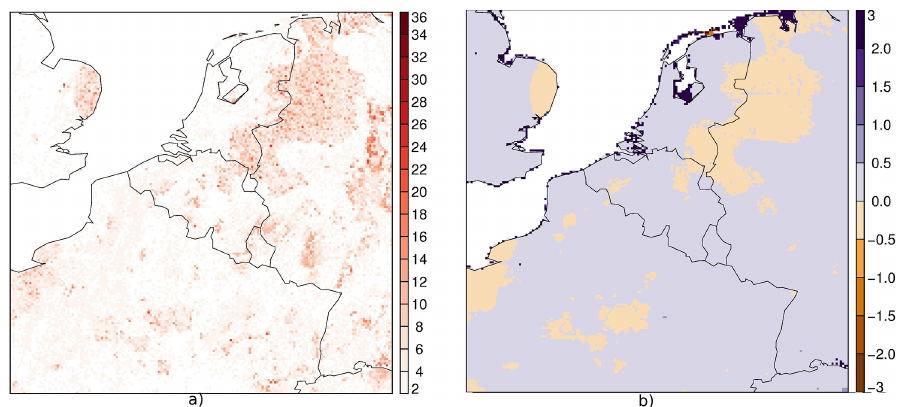
Figure 6. The number of the oscillations at every grid point for δ RH 2m /δW 2 (left) and the soil wetness index (SWI) of the deep soil layer (right) on 2 July 2010 for the offline reference run (REFofl) from 12:00 to 18:00UTC.